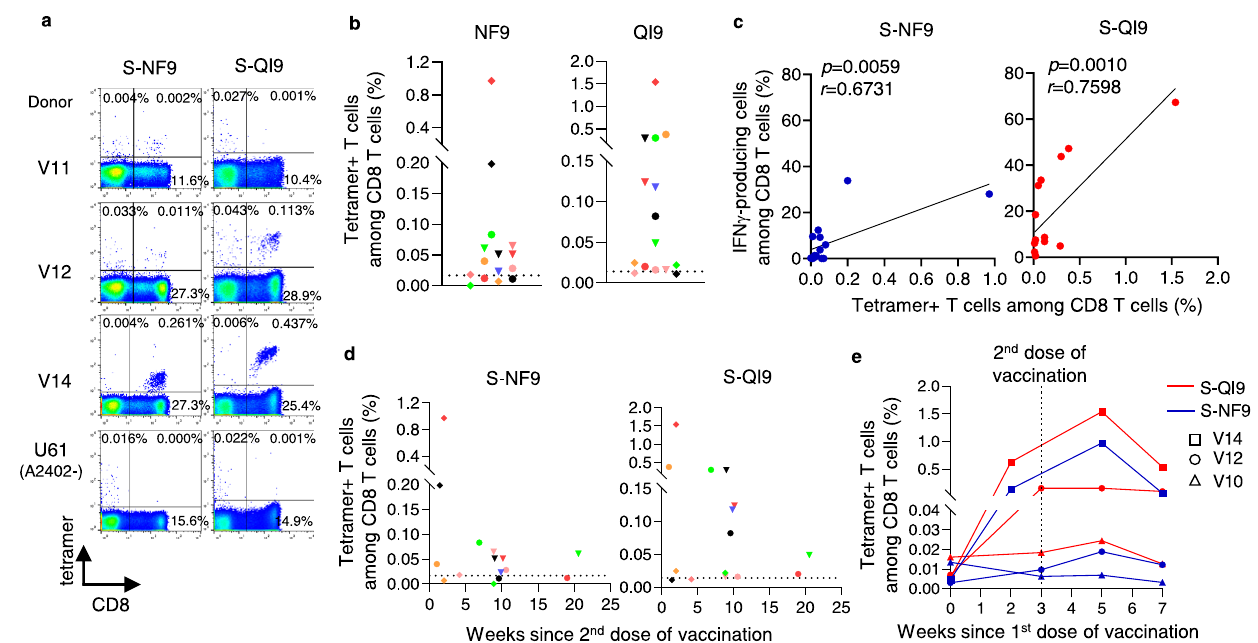
Fig. 2 | Analysis of CD8 + T cells speci fi c for two immunodominant epitopes in ex vivo PBMCs from HLA-A*24:02 + individuals vaccinated with an mRNA vac- cine. a Representative results of HLA-A*24:02-S-NF9-tetramer + or HLA-A*24:02-S- QI9-tetramer + CD8 + T cells in three vaccinated HLA-A*24:02 + individuals. U61 is a HLA-A*24:02-negative control. b Frequency of HLA-A*24:02-S-NF9-tetramer + or HLA-A*24:02-S-QI9-tetramer + CD8 + T cells in ex vivo PBMCs from 15 HLA-A*24:02 + individualscorrespondingtosamplesusedinFig.1a.Thedottedlinerepresentsthe threshold for positive binding. c Correlation between the frequency of tetramer-